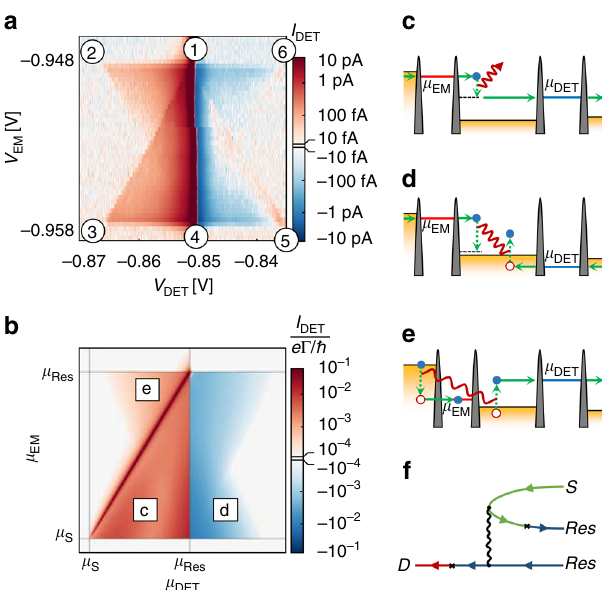
Fig. 3 Spectroscopy of quantum Hall edge channel transfer. a 2D-colour plot of the current through the Detector QD for varying Detector QD ( x - axis) and Emitter QD plunger gate voltage ( y -axis). The encircled numbers refer to the energetic points mentioned in the text and are explained in detail in the Supplementary Note 1. The signal is plotted on a logarithmic colour scale preserving the direction of electron tunnelling in the colour code. b Calculated current through the Detector QD for the experimental situation depicted in ( a ). Γ is the tunnelling rate through the QD. c – e schematic description of the electron scattering processes involved in the transfer. f Diagram corresponding to the process in ( e ), generating current in the triangle ① – ② –